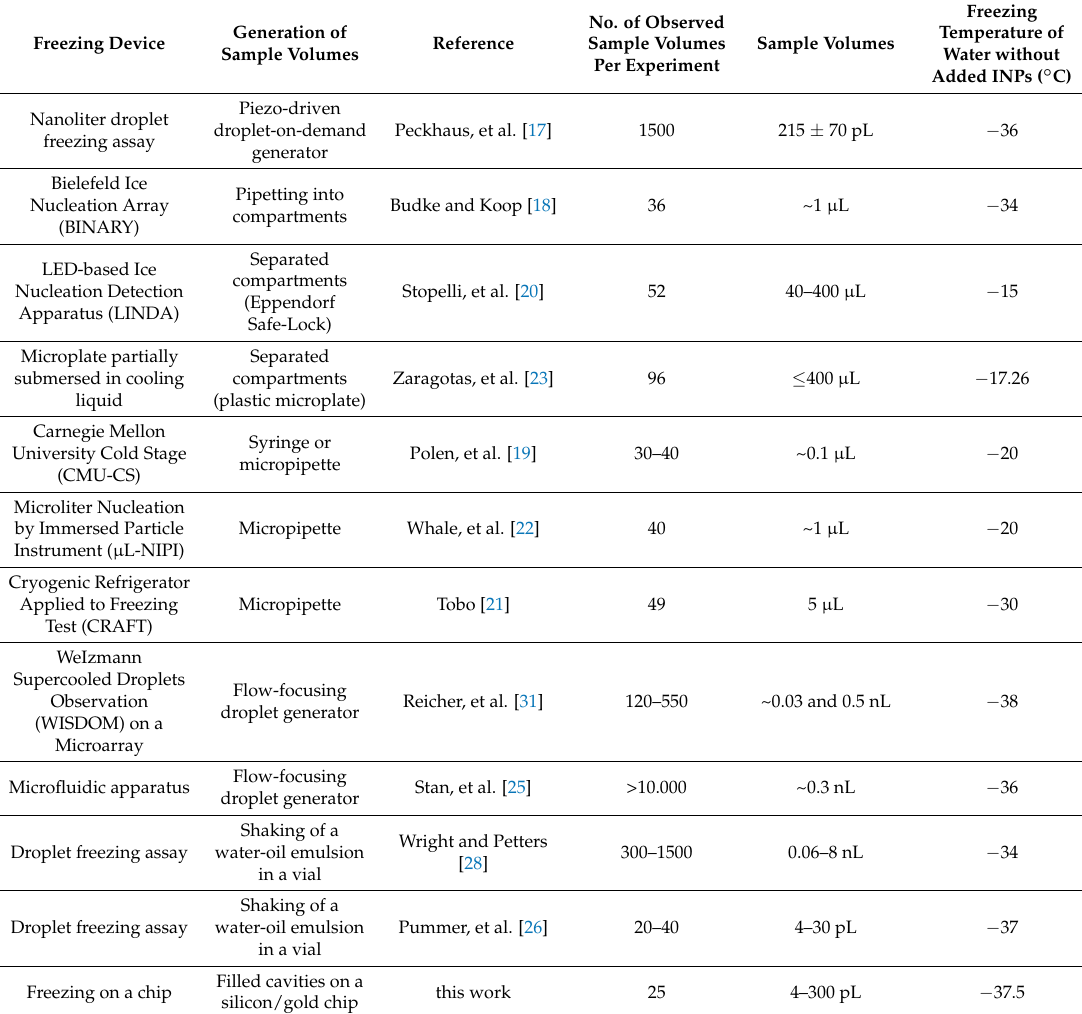
Table 1. Comparison of the main features of different lab bench freezing